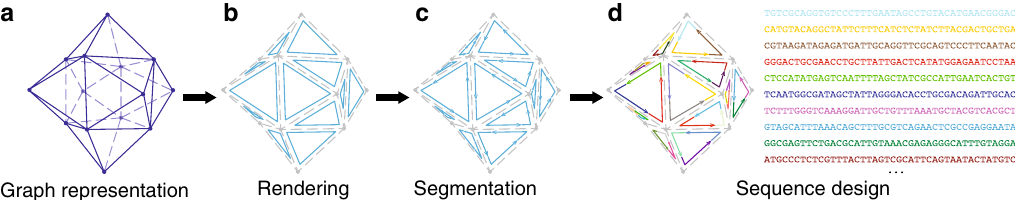
Fig. 1 Design pipeline for a typical wireframe structure composed of synthetic strands. a A speci fi c two-dimensional (2D) or three-dimensional (3D) graph representation of a targeted structure. b A node-edge network rendering. Nodes represent vertices of different numbers of arms and the edges represent duplexes of variable lengths. c Segmentation of edges into complementary domains. d Sequence generation of distinct component